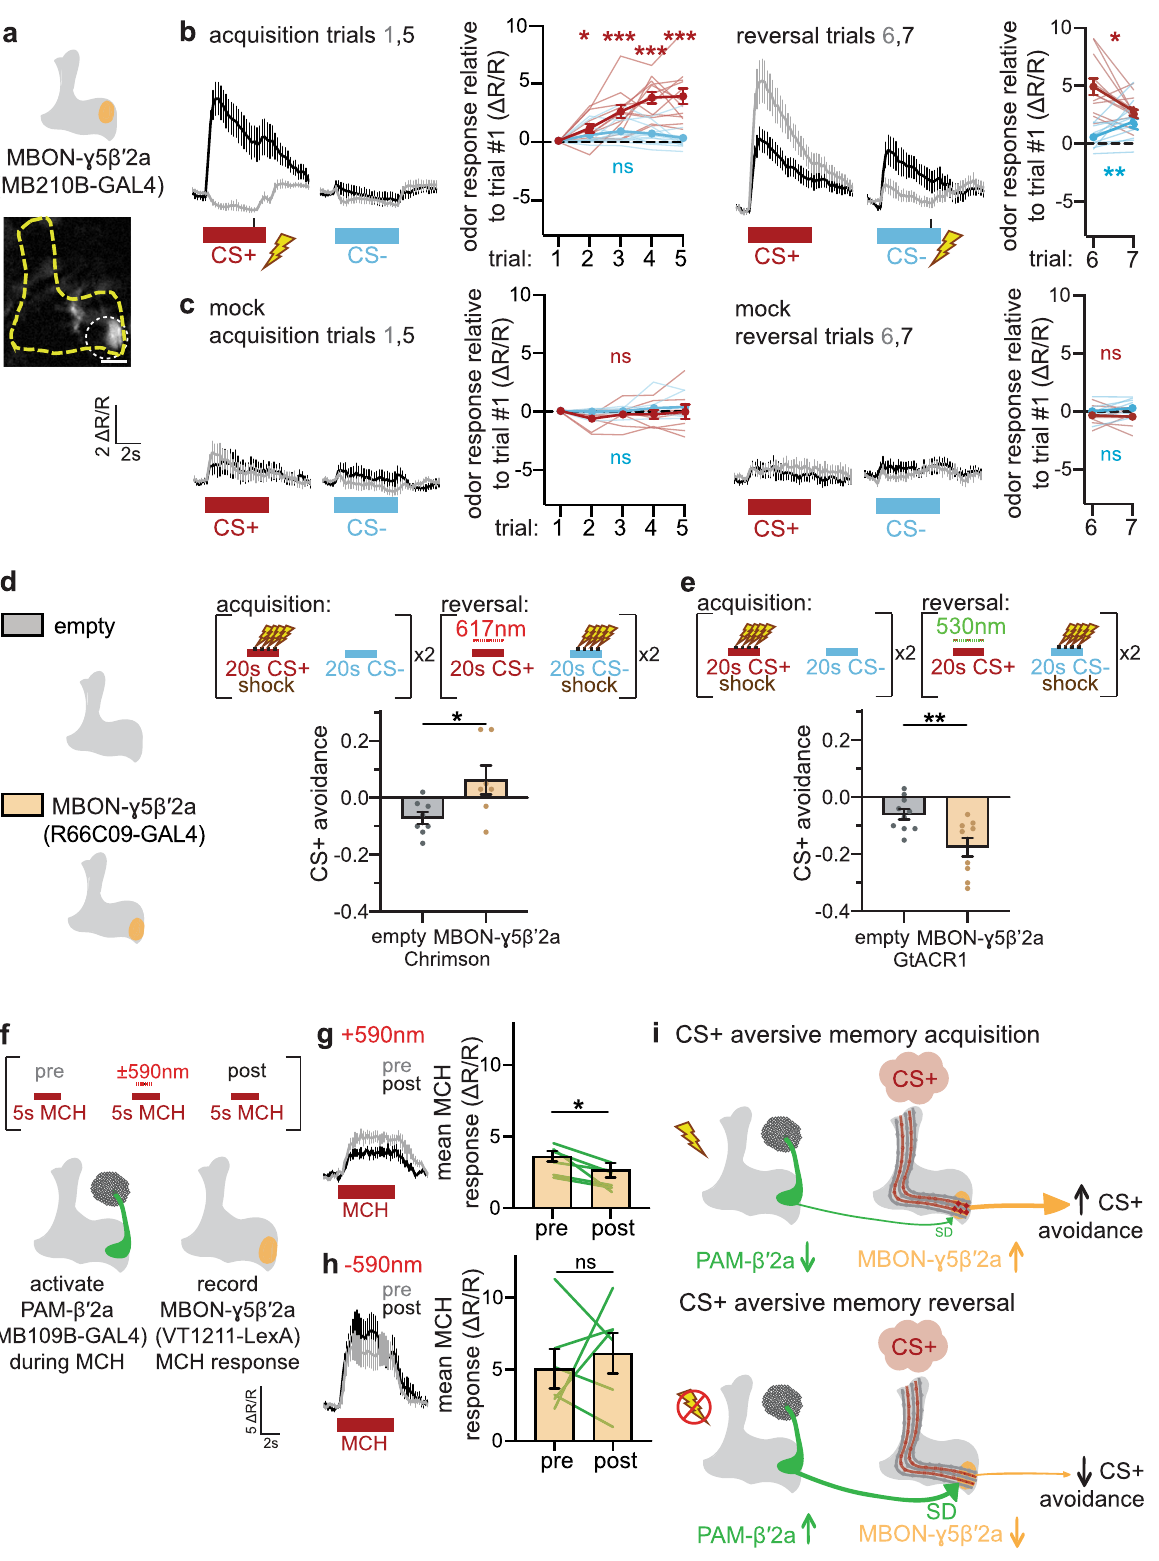
fi ndings are also consistent with how altering MBON activity in the presence of an odor can have reinforcing effects that change corresponding behavior towards the odor 58 – 60 . Although manip- ulating other MBONs could also lead to the changes in behavior observed in Fig. 5b, c, our imaging data suggest that these two MBONs are the likely MBONs involved in driving